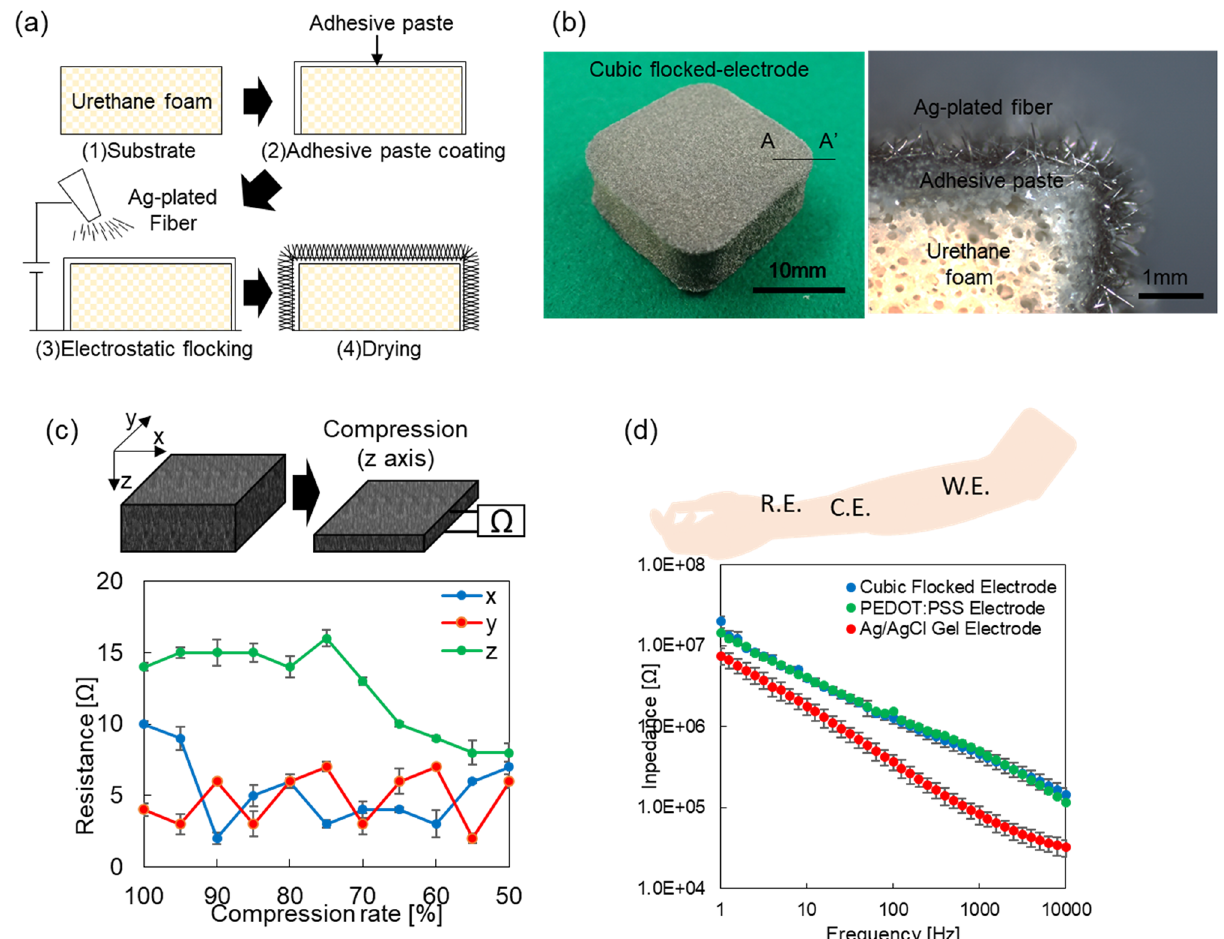
Figure 1. Picture and fundamental evaluation of the cubic flocked electrode fabricated in this work. ( a ) Image of CFE fabrication process using electrostatic flocking technology. ( b ) Photograph of the CFE and cross- sectional view (at the A-A’ line). ( c ) Resistance changes in the CFE when compressed in the directions of the x , y , and z axes. ( d ) Impedance spectra of the CFE, PEDOT:PSS electrode, and Ag/AgCl gel electrode, measured in the 1 Hz to 10 kHz frequency range when in contact with skin (forearm) at 200 Pa. The spectra show the mean values and standard errors (measurements were taken five